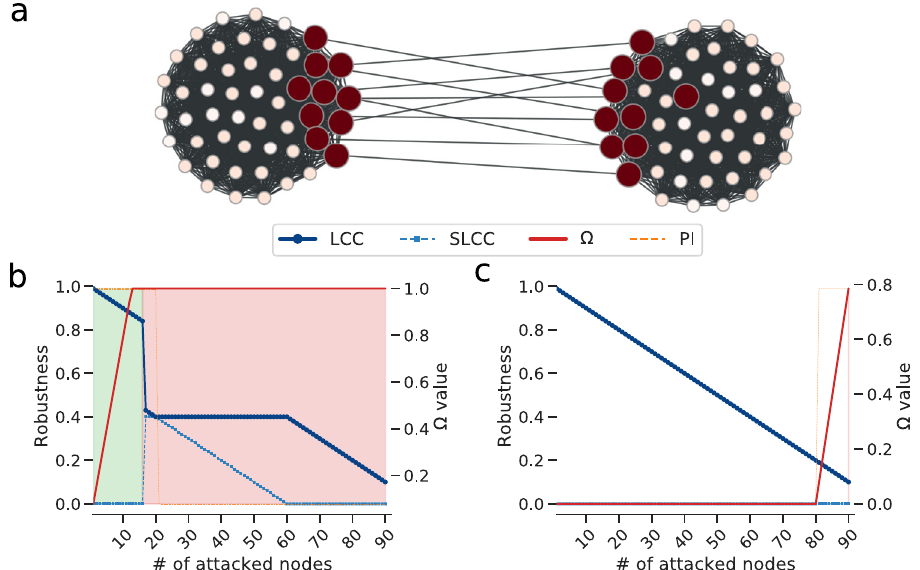
Fig. 7 Why do we need an early-warning signal? Toy-example meant to explain why the LCC is not suf fi cient to evaluate the state of the system: in ( a ) we show a toy-example network composed of two cliques connected by 10 bridges. The size of the nodes represents their betweenness value and the color (from dark red to white) represents their importance to the system ’ s health according to our method. As illustrated in ( b ) and ( c ), the LCC decreases at the same rate during the initial part of both a betweenness and an inverse betweenness-based attacks. Instead, Ω values do not and reach warning levels before the system suddenly collapses. Note that LCC and SLCC are the largest and second-largest connected components respectively, Ω is the early- warning descriptor introduced in this study, and PI is the p n value of each removed node.